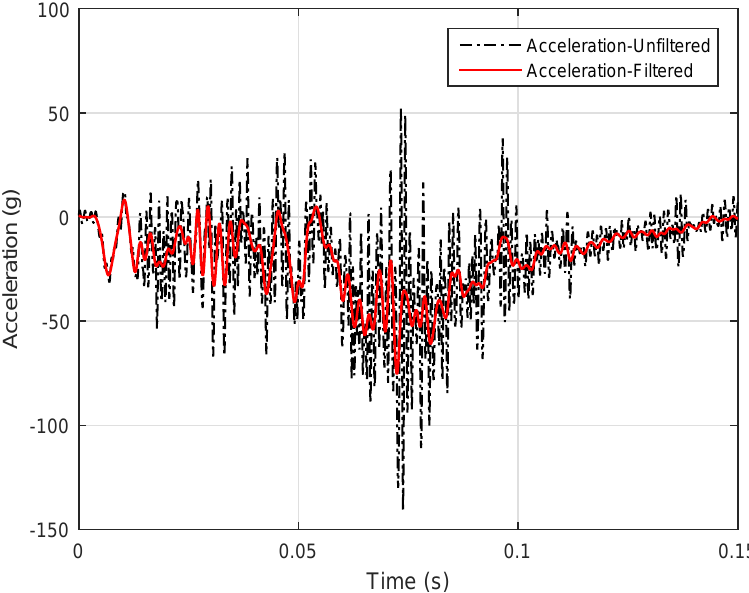
Figure 2. Noisy and filtered acceleration signals for full-scale frontal crash